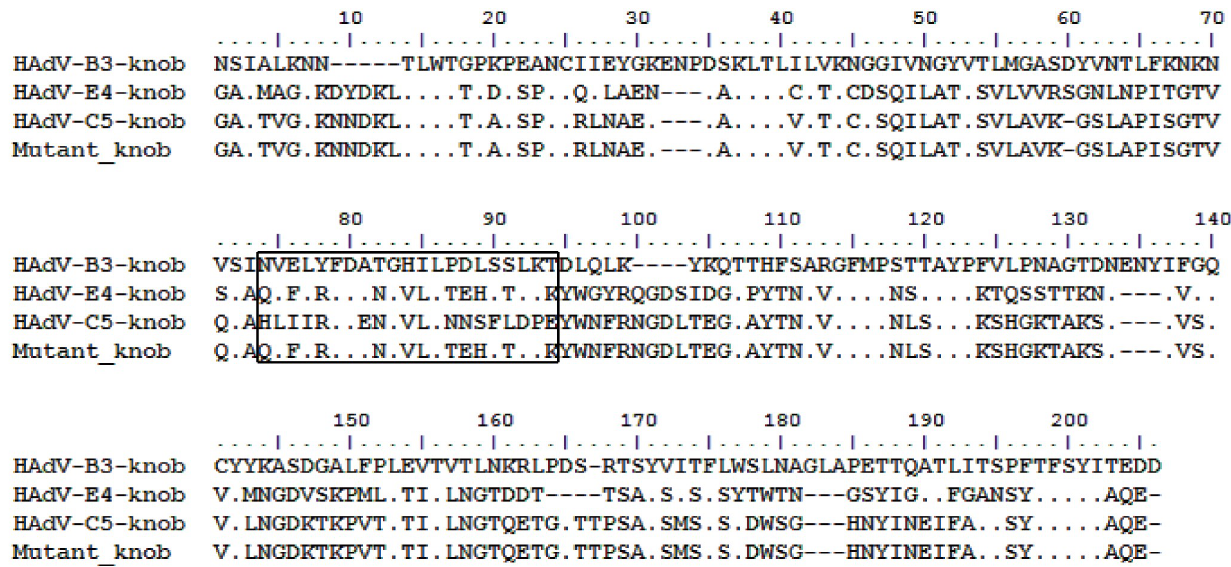
Fig 7. Multiple alignment of amino acid sequences of the knob proteins of HAdV-B3, E4, and C5 and mutant knob protein. The multiple alignment results showed that, compared with the sequences outside of the boxed region, the amino acid sequence (residues 71–91) of HAdV-E4 was found to be more similar to that of HAdV-B3 (residues 69–89) than to that of HAdV-C5 (residues 70–90) within the boxed region. The amino acid fragment of the HvdA-E4 knob protein within the boxed region was predicted to be the linear epitope. The mutant knob protein was designed by replacing the amino acid sequence of the HAdV-C5 knob protein within the boxed region with the amino acid sequence of the predicted linear epitope.